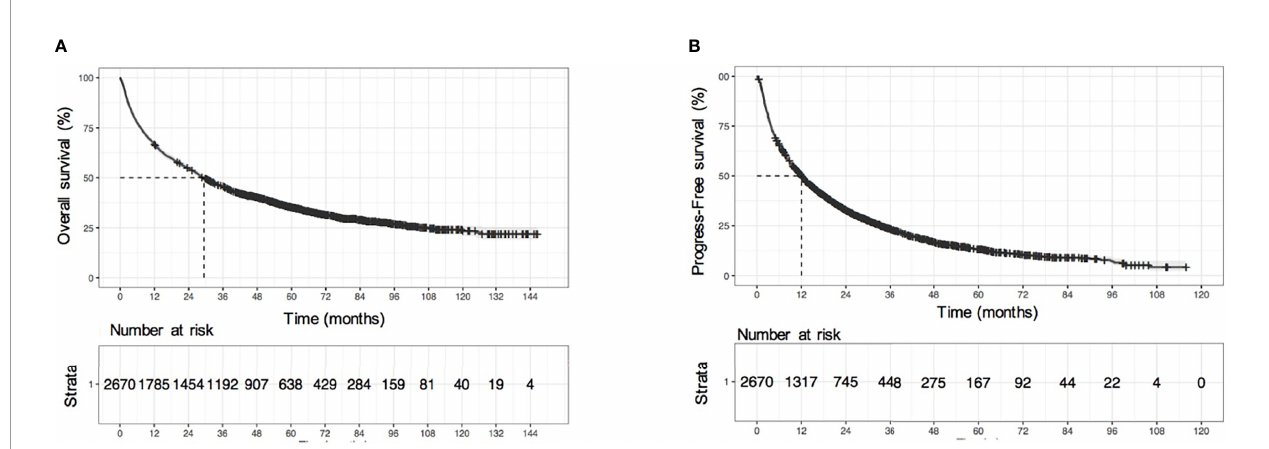
FIGURE 1 | Survival analysis of all HCC patients. (A) KM survival curves of overall survival (OS), (B) KM survival curves of progression-free